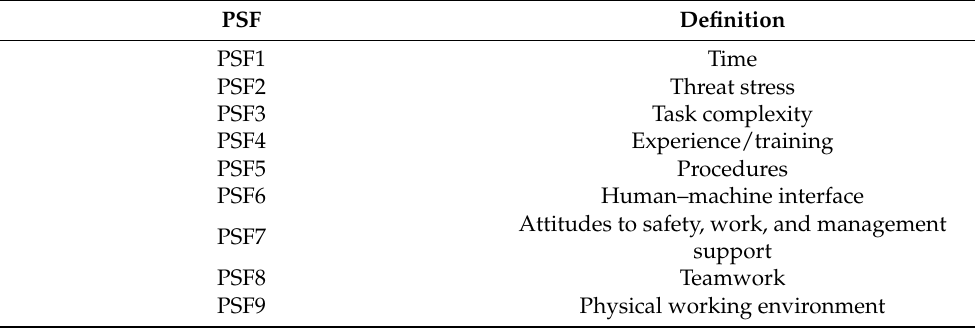
Table 1. The nine PSFs and the corresponding definitions in Petro-HRA